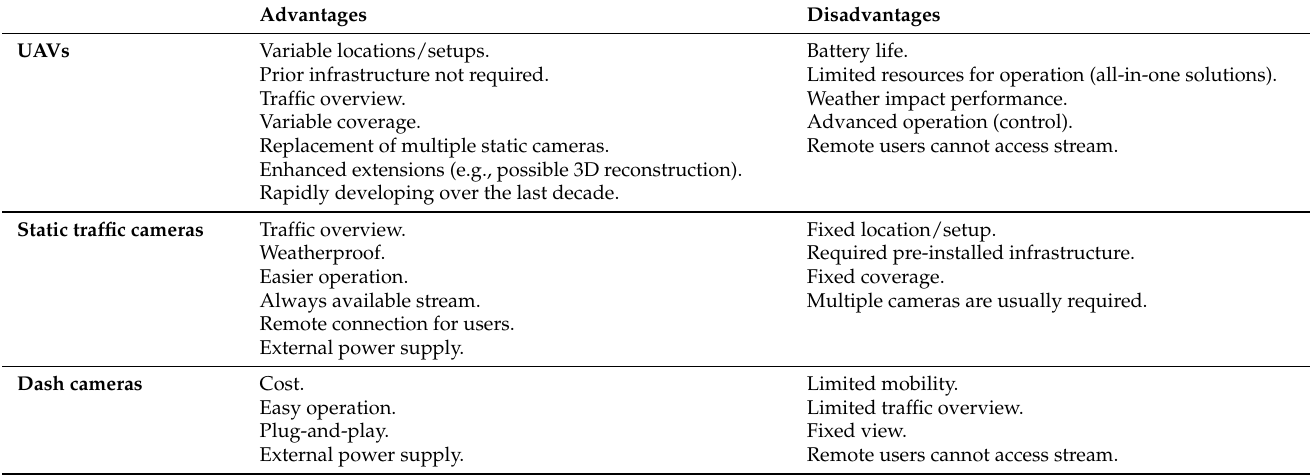
Table 1. Comparison of monitoring mechanisms: UAV, static camera, dash